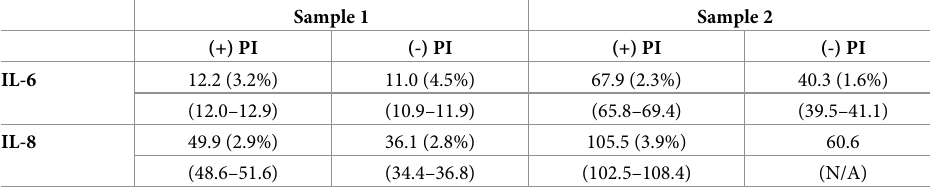
Table 2. Cytokine concentrations with and without protease inhibitor use during homogenization.